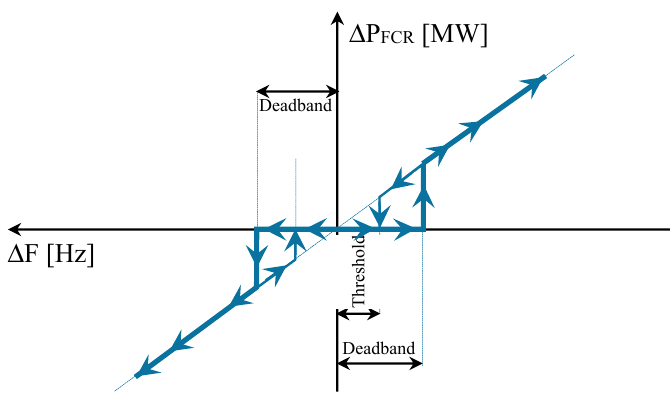
Figure 6. FCR ancillary service regulation patterns